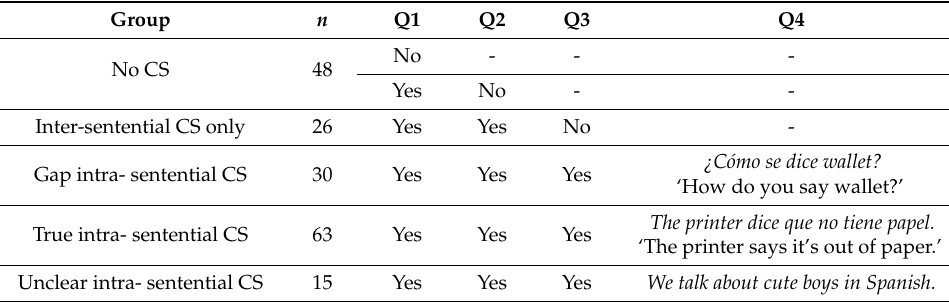
Table 1. Summary of bilingual language